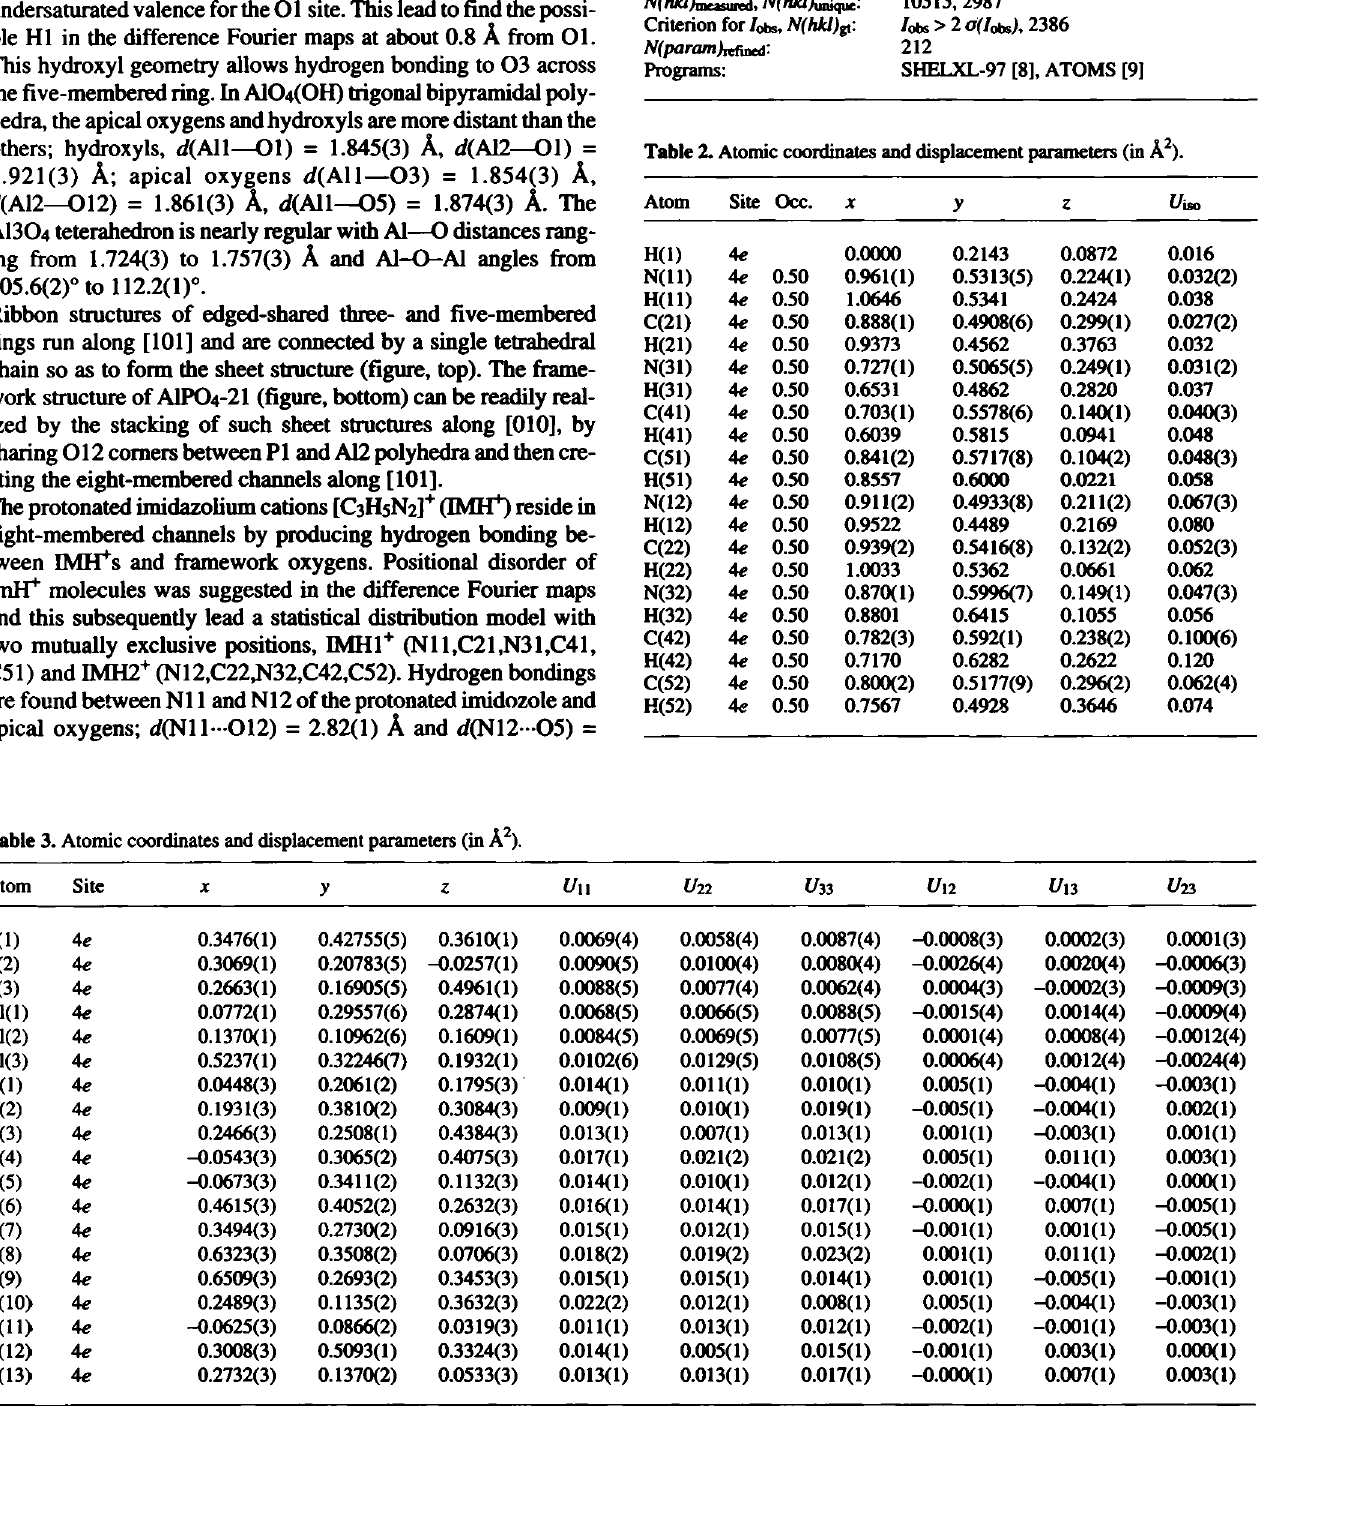
Table 1. Data collection and handling.